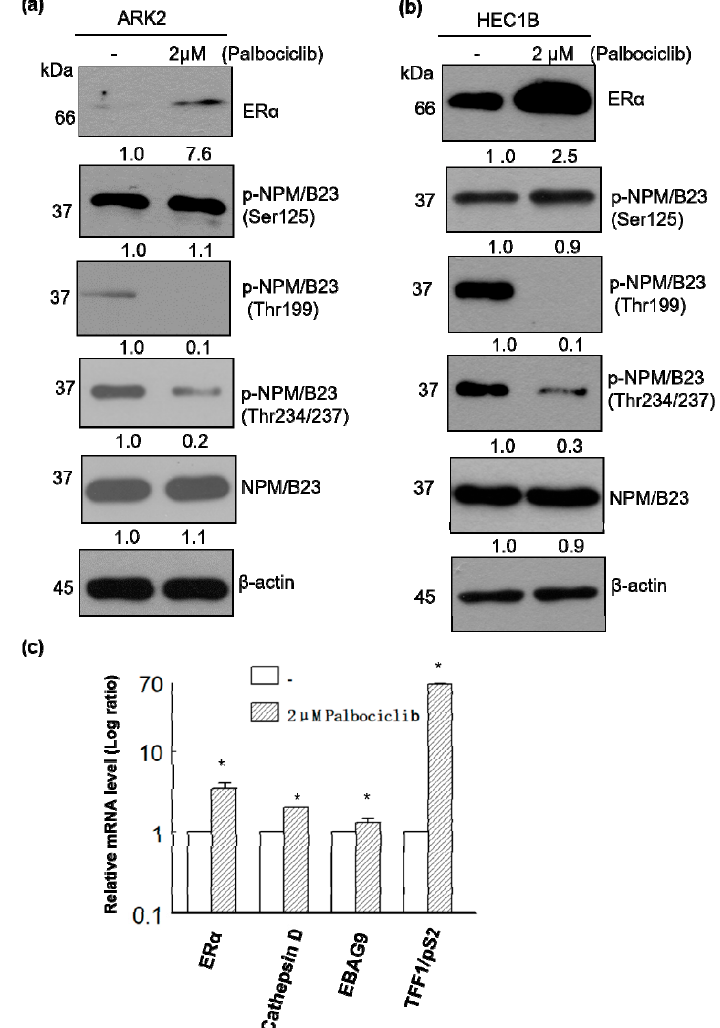
Figure 1. Palbociclib induces ER α expression and promotes NPM / B23 dephosphorylation at multiple sites in endometrial cancer cells. ( a , b ) Palbociclib (2 µ M) was used to treat ARK2 (left panel) and HEC1B cells (right panel) for 24 h. Cell lysates were subsequently resolved on SDS-PAGE and subjected to immunoblotting with antibodies raised against ER α , phospho-NPM/B23 (Ser125), phospho-NPM/B23 (Thr199), phospho-NPM/B23 (Thr234/237), NPM/B23, and β -actin. Densitometry-derived values (bottom) are normalized with the control (-) that was set as 1. Data shown are derived from three independent experiments. β -actin serves as the loading control for normalization. ( c ) Palbociclib-treated ARK2 cells were collected and mRNA expression levels for ER α , cathepsin D, EBAG9, and TFF1/pS2 were analyzed using real-time qPCR (primers described in the Methods section). Data are expressed as means ± standard errors from three independent experiments. * p < 0.05 compared with controls.